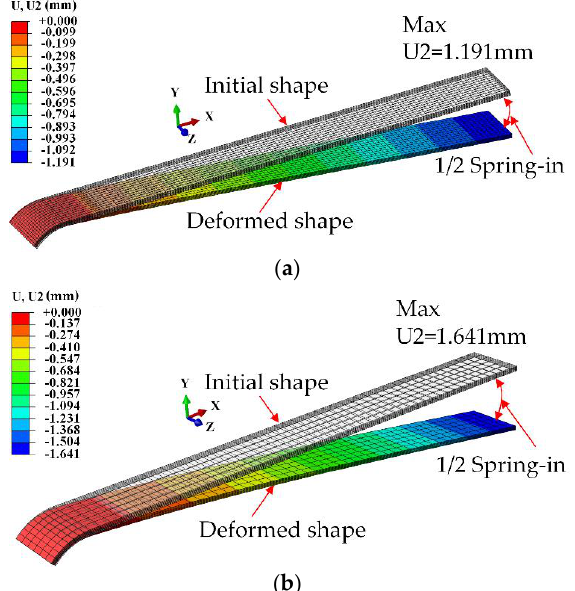
Figure 6. Predicted displacement nephogram and spring-in angle for a L-shaped part with [0/90 2 ] s lay-up: ( a ) without shear layer; ( b ) with shear layer. (The deformation scale factor is 8).